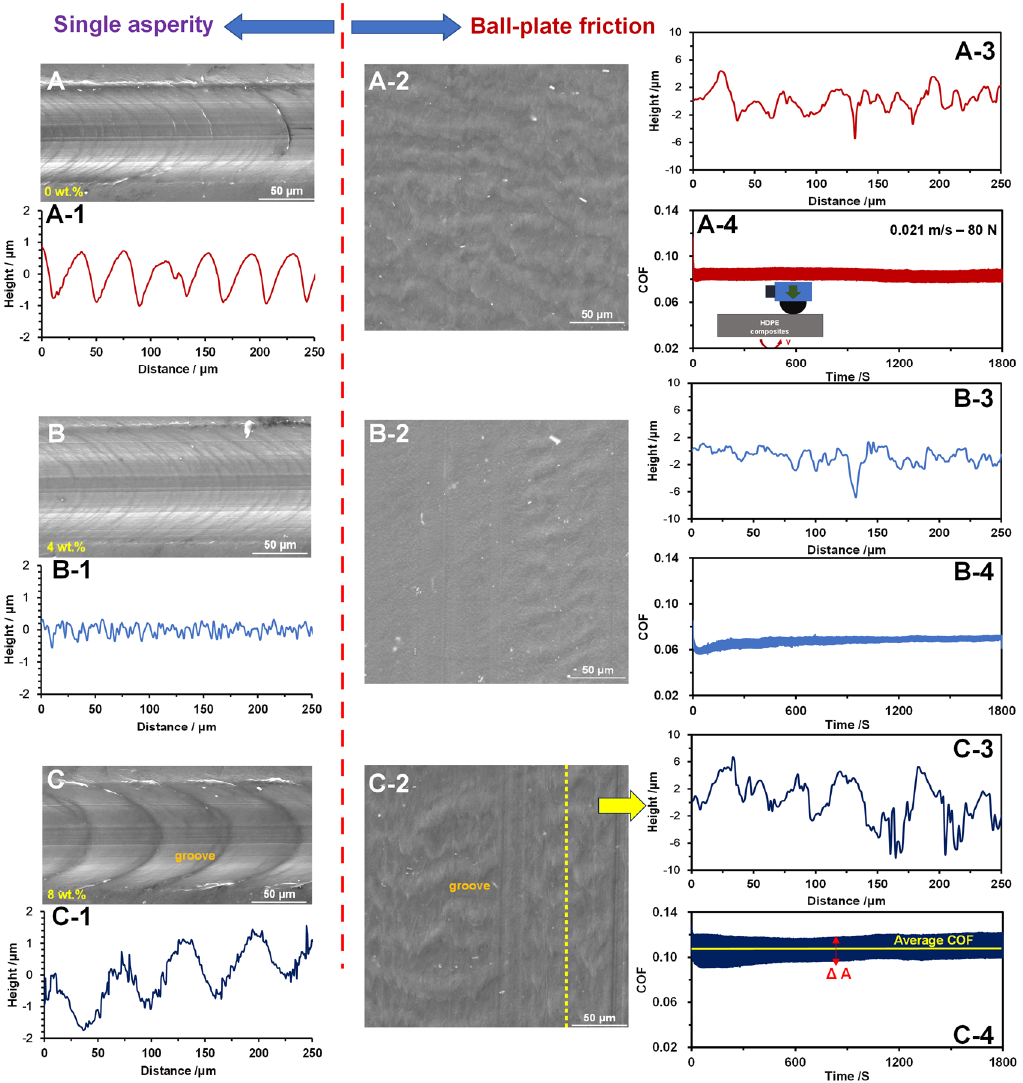
Figure 8. Frictional responses of the HDPE with different contents of Si 3 N 4 from the single-asperity test and the universal friction test: ( A – A-4 ) 0 wt.%; ( B – B-4 ) 4 wt.%; ( C – C-4 ) 8 wt.%.